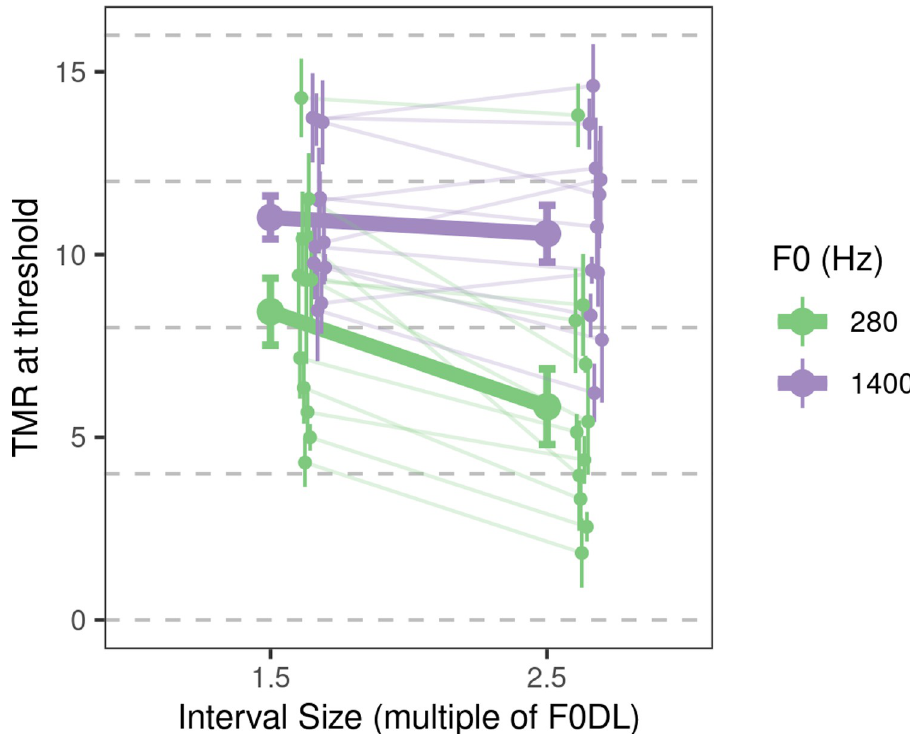
Fig 3. Behavioral results from Experiment 2. Results from Experiment 2. Large filled circles and error bars indicate the average TMR and ± 1 standard error of the mean (SEM). The small filled circles and error bars indicate individual F0DLs and ± 1 SEM for each